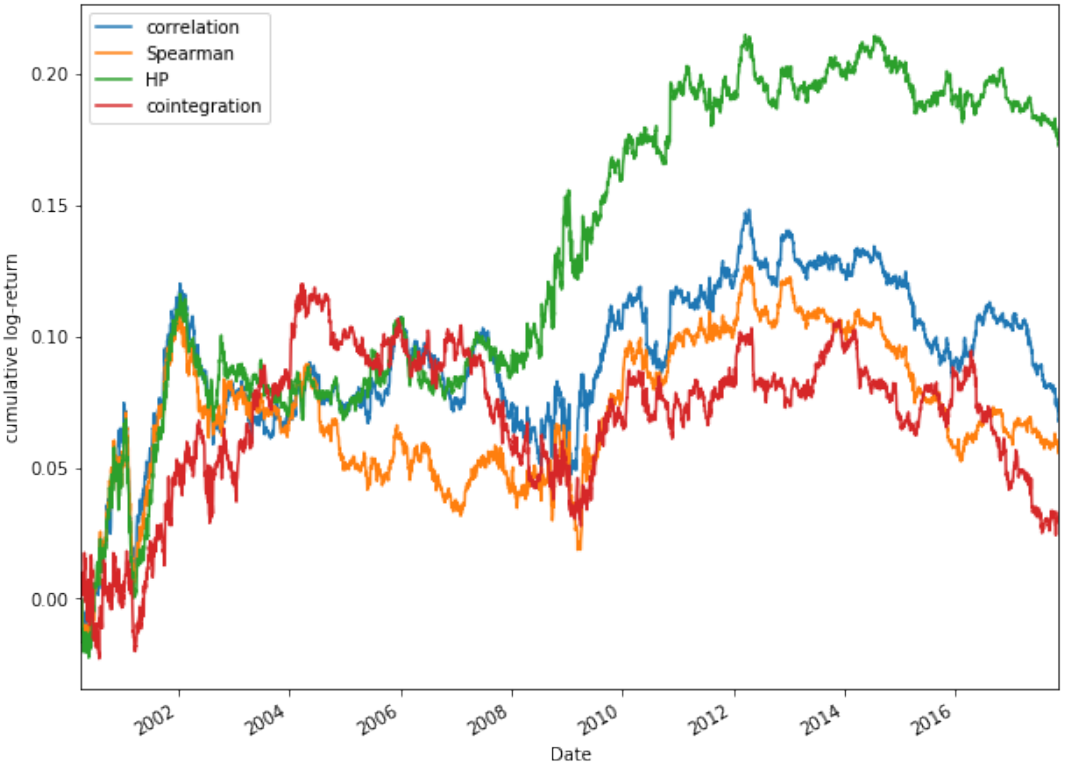
Figure 23. Comparative cumulative log-return of a 15-pair portfolio between Pearson’s